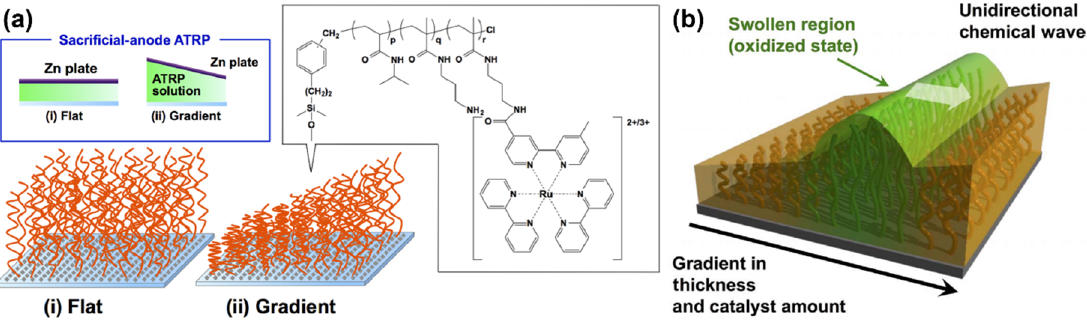
Figure 7. ( a ) Preparation of flat and gradient self-oscillating polymer brushes by sacrificial anode ATRP. The chemical structure of the oscillating polymer is shown in the inset. ( b ) Illustration of the self-oscillating gradient polymer brushes showing the unidirectional propagation of chemical waves generated by the Belousov–Zhabotinski reaction. Adapted and reproduced from [87], American Association for the Advancement of Science, 2016.